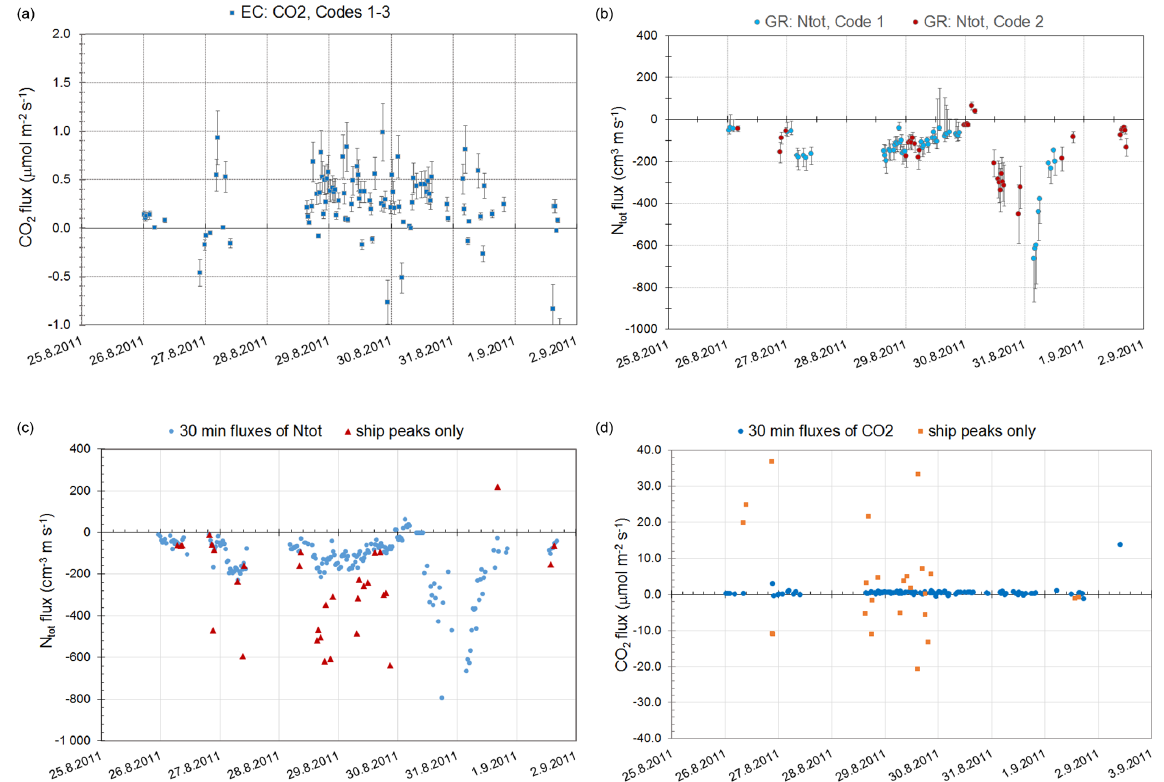
Figure 11. Time series of 30min fluxes for CO 2 (µmolm − 2 s − 1 ) using the EC method (a) under all wave conditions (codes 1 to 3), and N tot (cm − 3 ms − 1 ) using the GR method (b) with no swell (codes 1–2), along with the uncertainties. The data in panels (a) and (b) only include events in the wind sector between 150 and 270 ◦ and with the stationary criteria based on the momentum flux for N tot and the CO 2 flux for CO 2 . (c) Time series of the 30min fluxes of N tot using the GR method in the 150–270 ◦ wind direction. Additionally, the fluxes of ship peaks are shown separately. Panel (d) is the same as panel (c) but for CO 2